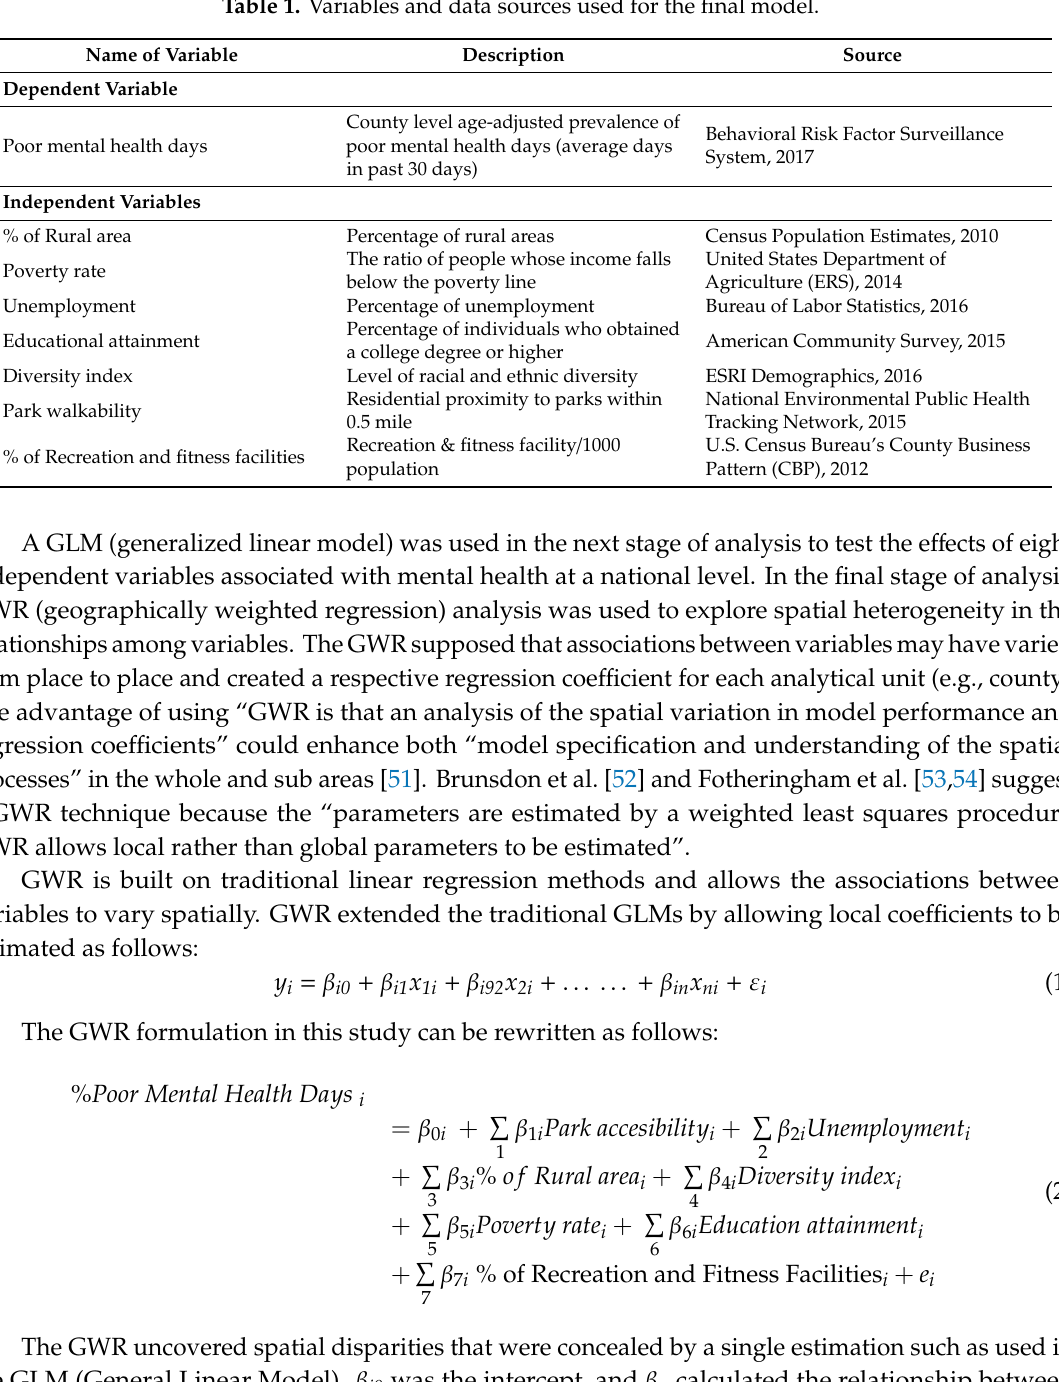
Table 1. Variables and data sources used for the final